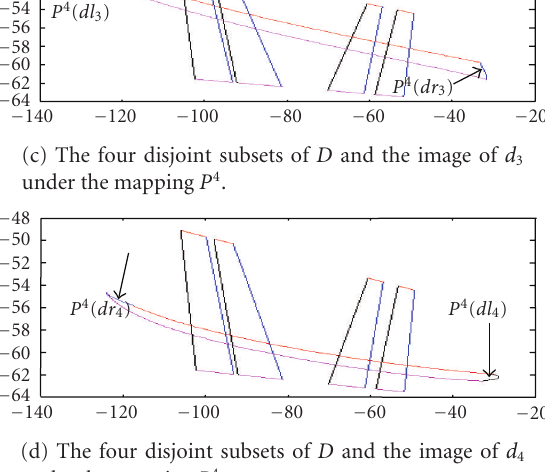
Figure 4.2. The four disjoint subsets of D and their images under the mapping P 4